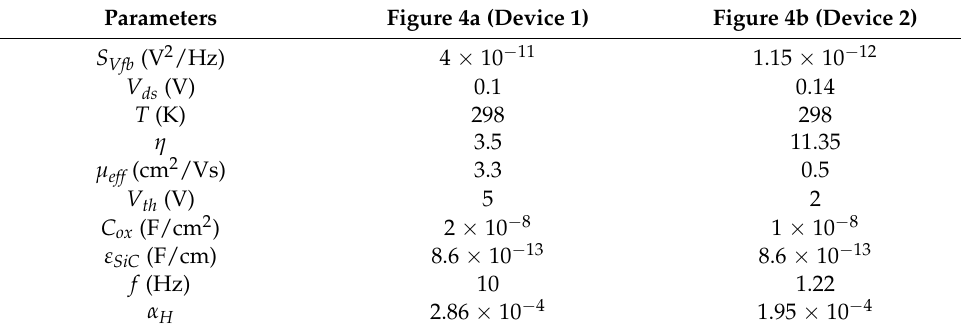
Table 1. Parameters used for model simulations in Figure 4.